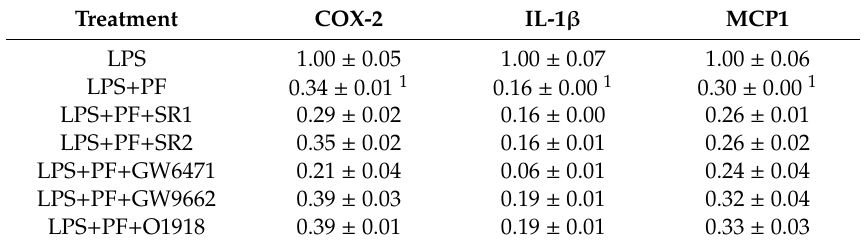
Table 2. E ff ect of CB receptor or PPAR antagonist to anti-inflammatory response by PF3845 in LPS. Treatment COX-2 IL-1 β